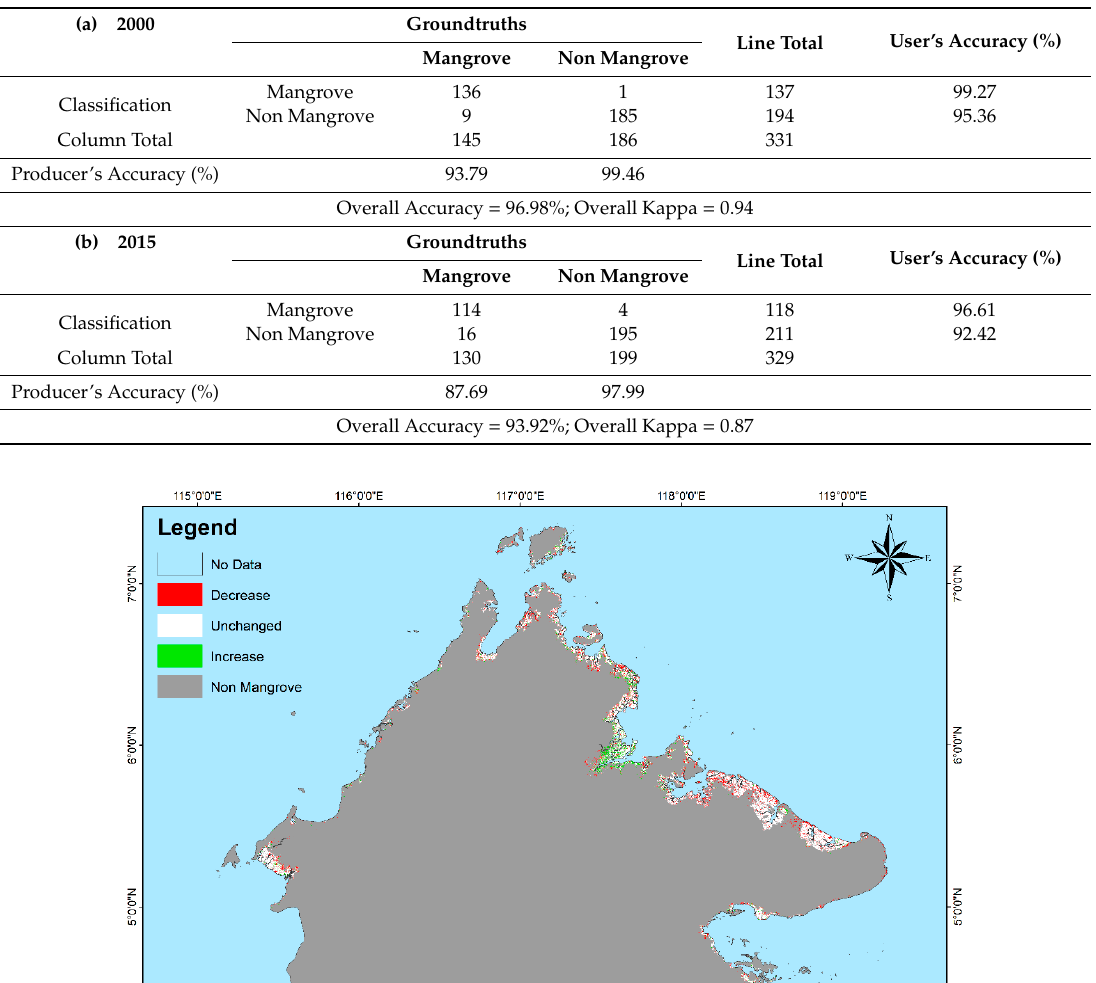
Table 4. Classification Accuracy for Mangrove 2000 and 2015.